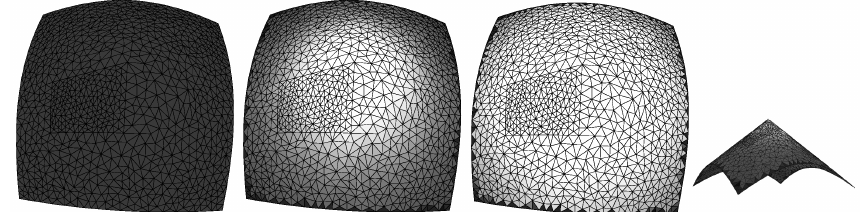
Fig. 6. Water flow on the same triangulated irregular mesh as use for the previous simulations, but now stretched over a cone. The first three images show the soil moisture (white = dry, black = wet) at the beginning and after 10 and 20 time steps, respectively. The cone is observed from the top. The most right image is a side view of the